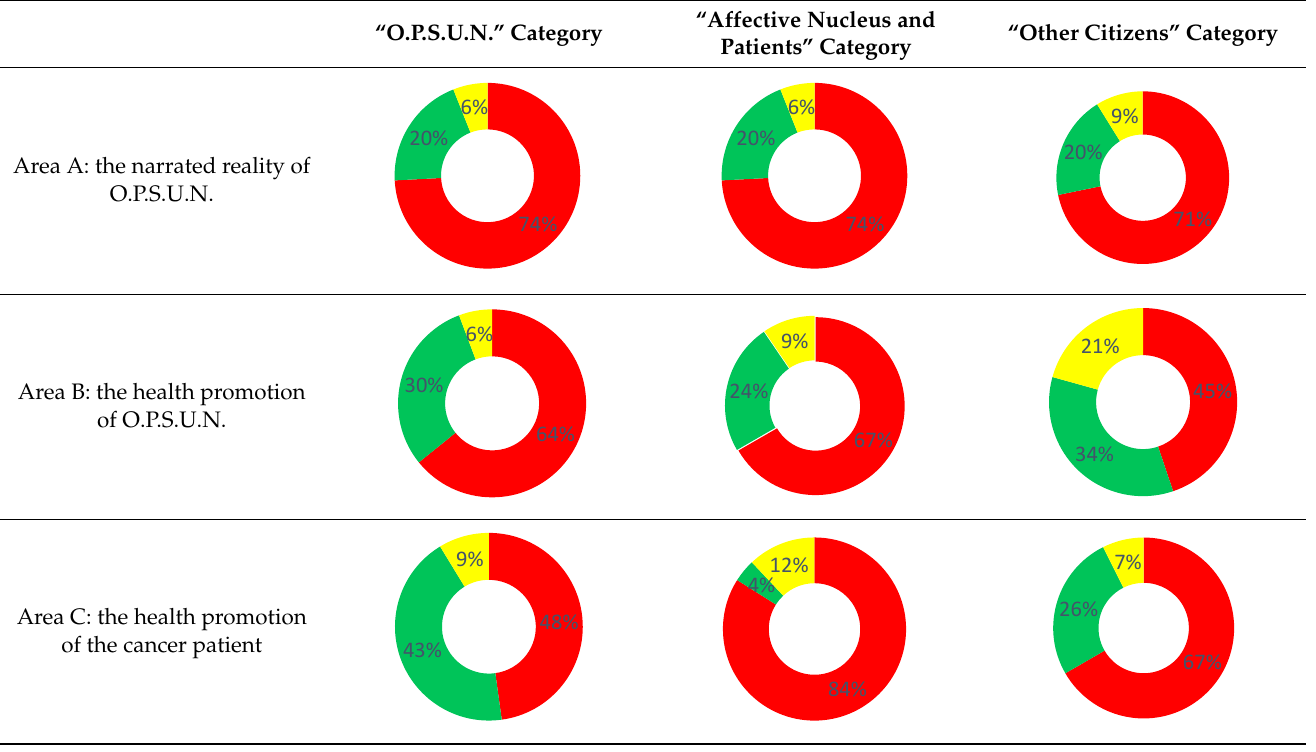
Table 1. Distribution of the repertory types by respondents’ category and by investigated area.